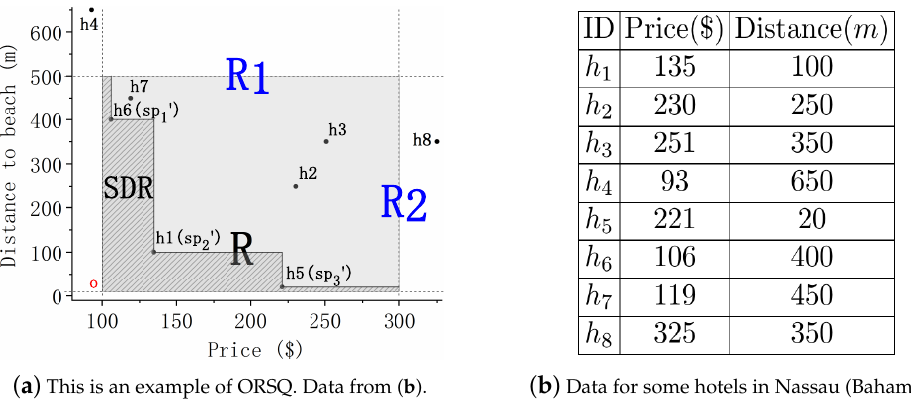
Figure 2. An example of ORSQ based on Nassau hotel real data